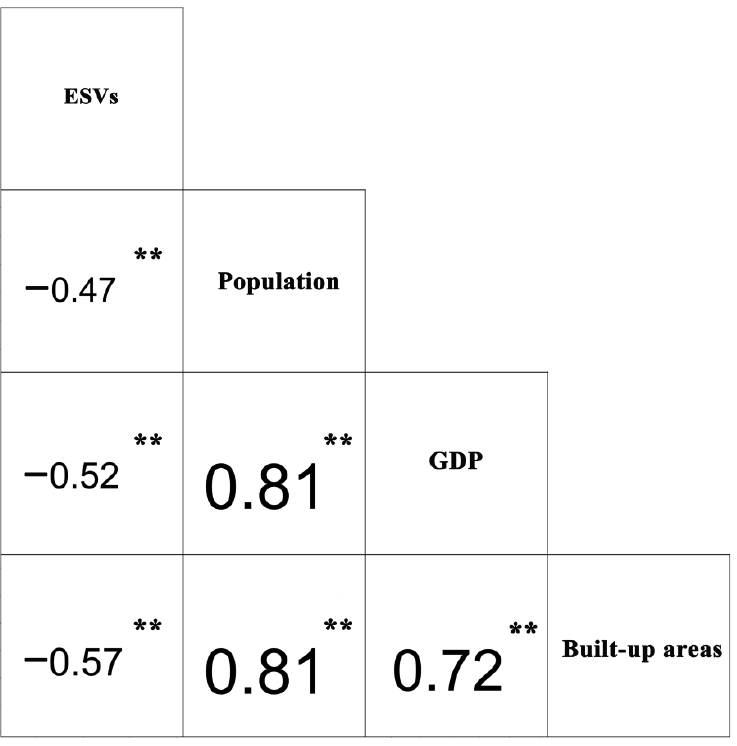
Figure 7. Analysis of the relationships among the ESVs, population, GDP, and built-up areas in the towns of Weifang. Note: ** indicates significance ( p < 0.05).